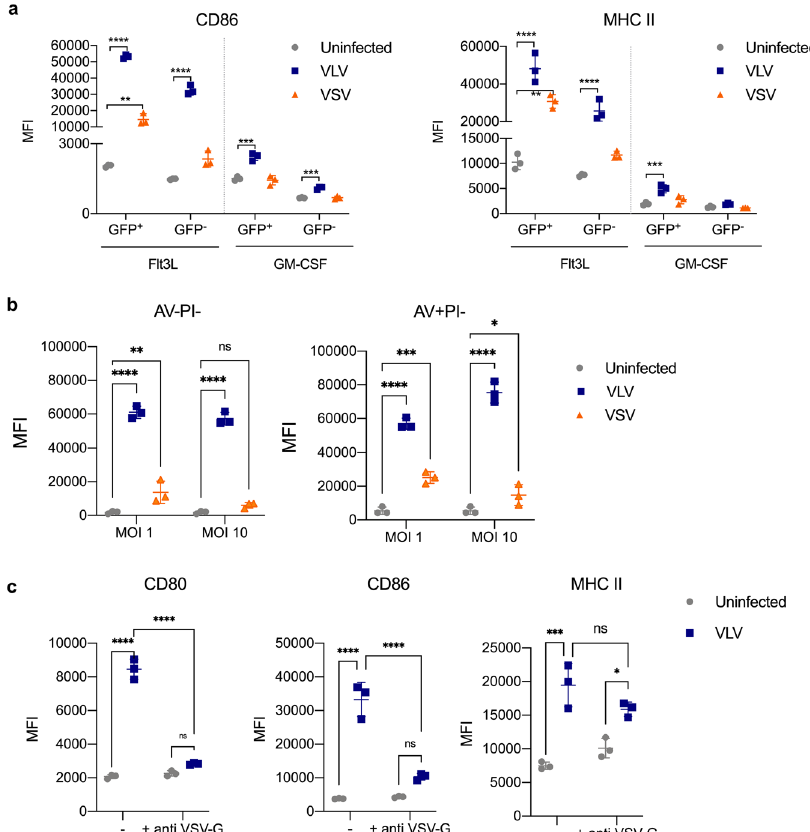
Fig. 4 Bystander activation of DCs with VLV but not VSV. Flt3L and GM-CSF DCs were infected with VLV or VSV (MOI 10) for 18 h. After infection, surface expression of the activation markers a CD86 and MHC II was analyzed in both infected (GFP + ) and uninfected (GFP − ) cells by fl ow cytometry. b Surface expression of CD86 in live cells (AV − PI − ) and early apoptotic cells (AV + PI − ). c VLV was pre-incubated with anti-VSV antibody prior to infection of Flt3L DCs, and CD80, CD86, and MHC II were measured 18 h post-infection. Data are expressed as mean ± standard deviation. ** p < 0.01, *** p < 0.001, **** p < 0.0001 compared to uninfected control by one- or two-way T cells (Fig. 9a). In contrast, the absence of cDC1 in VSV-induced responses appeared to mostly affect the production of CD8 + T cells expressing both TNF- α and IFN- γ (Fig. 9a).